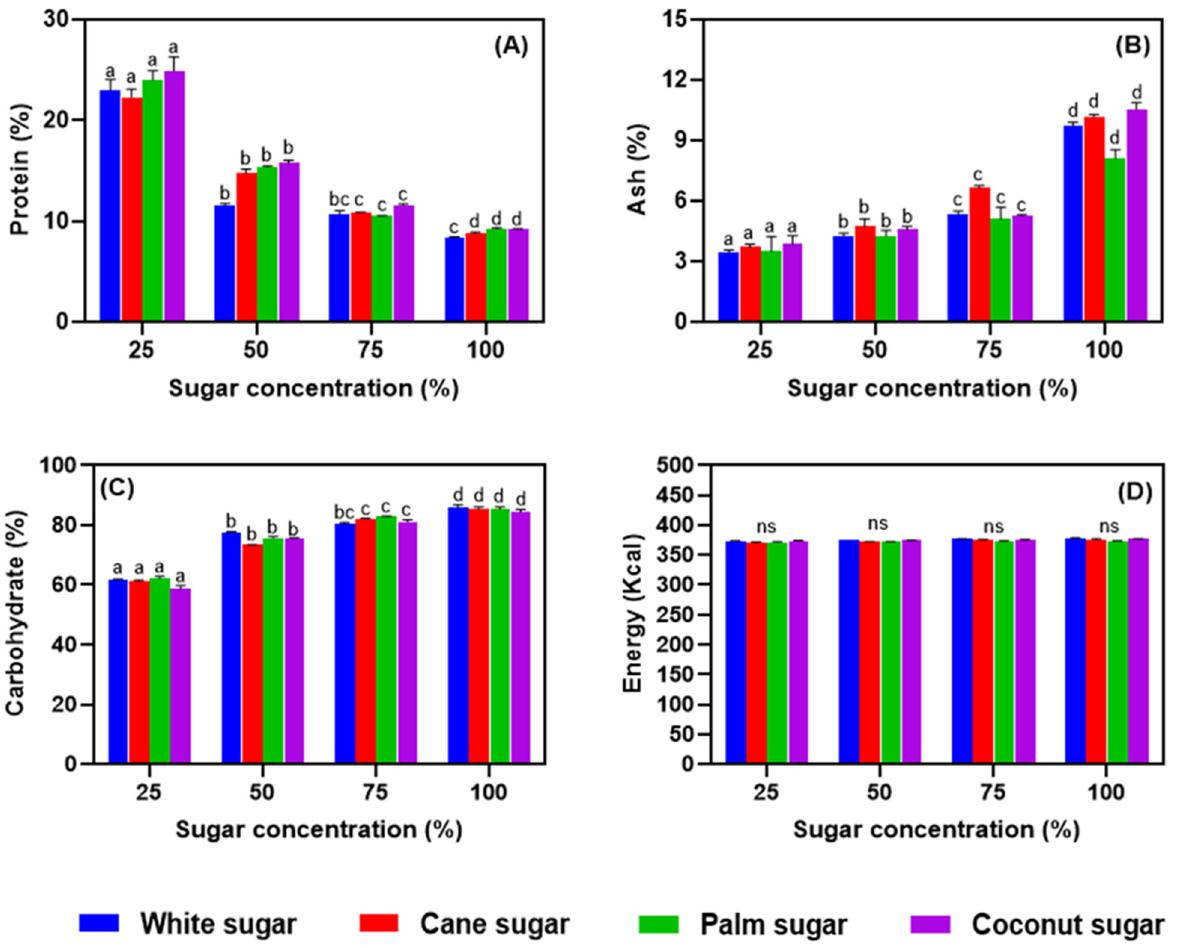
Figure 6. Proximate composition ( A – D ) of salted duck egg white meringues prepared with alternative types of sugar at various levels in the formulation. Different alphabets above the bars indicate significant differences among various conditions.